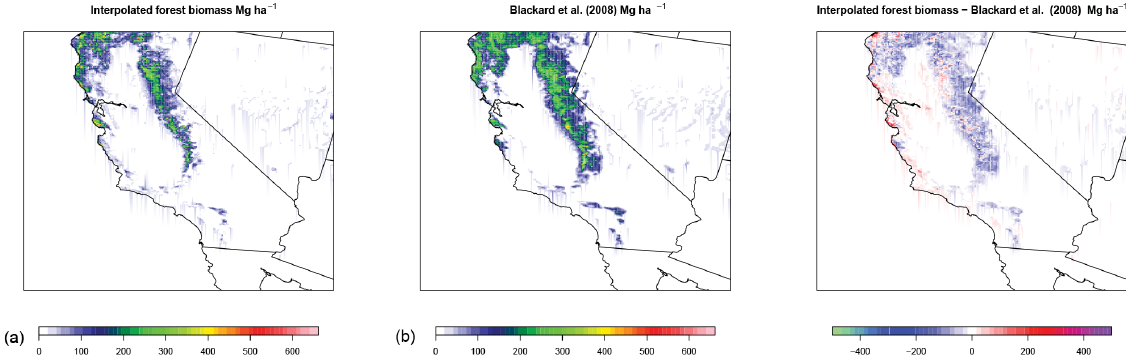
Figure 2. Total aboveground forest biomass (Mgha − 1 ) estimates for BELD 4 (a) , Blackard et al. (2008) (b) projected onto the 4km California model domain, and BELD 4 – the 4km projected Blackard et al. (2008) (c)